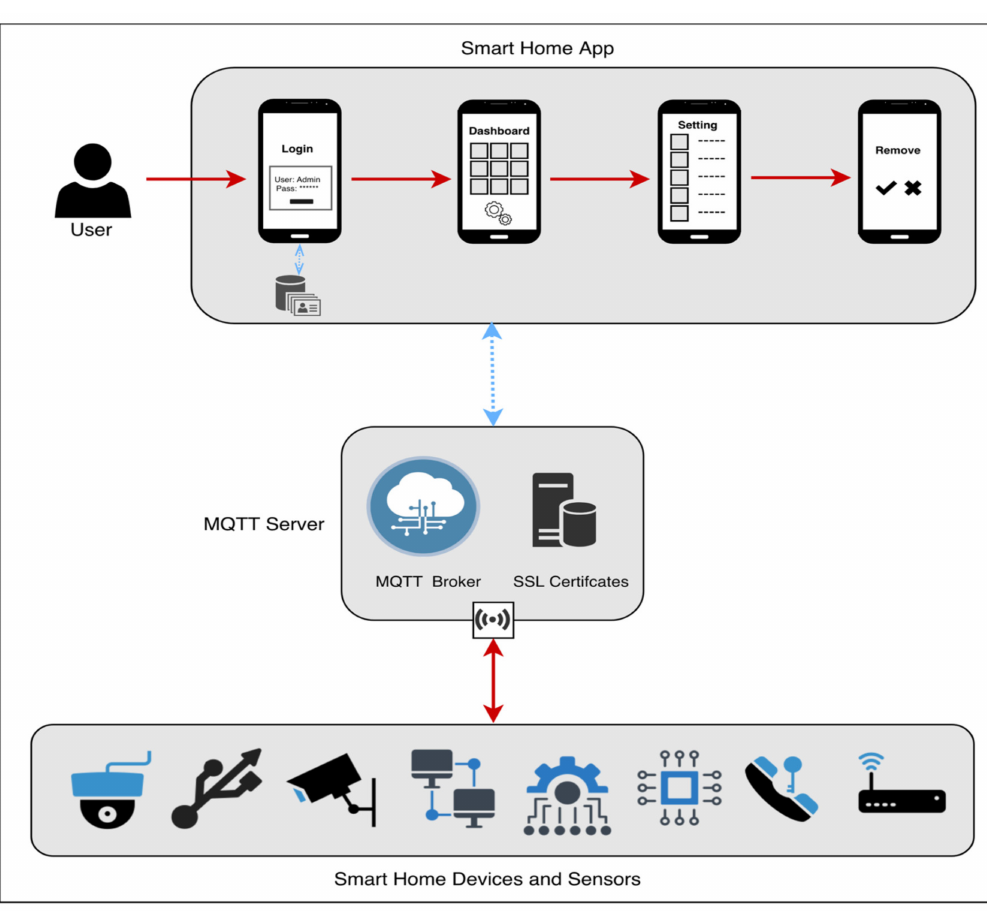
Figure 4. The conceptual smart home MQTT model.